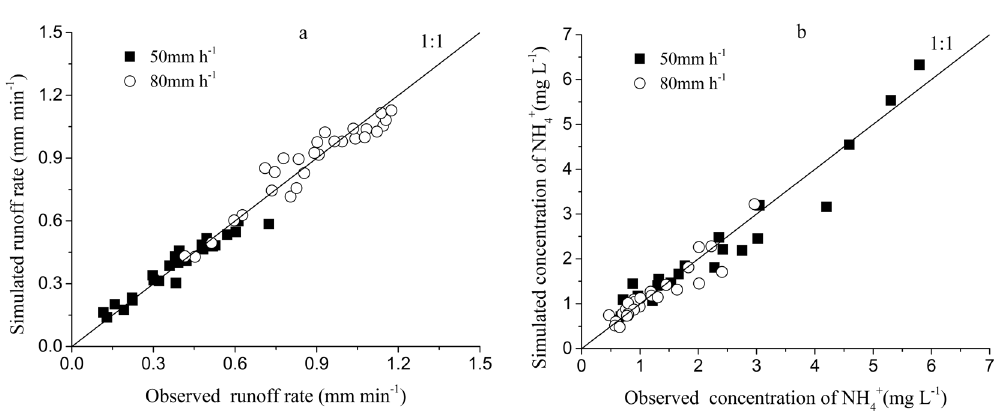
Figure 6. Simulated versus observed graphs for the runoff rate and the concentration of NH 4 + in